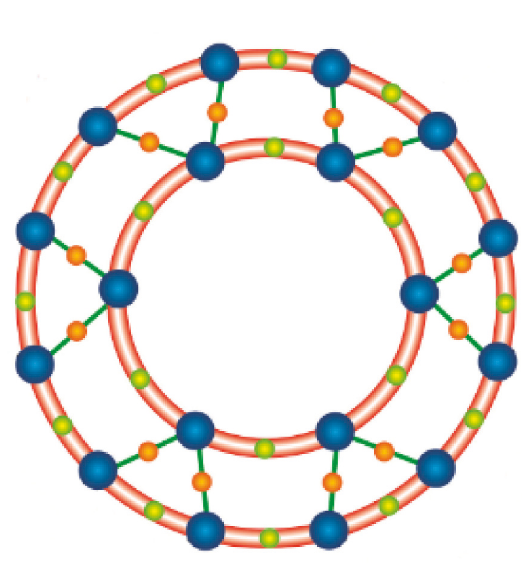
Figure 2: Basic metal organic network [47].